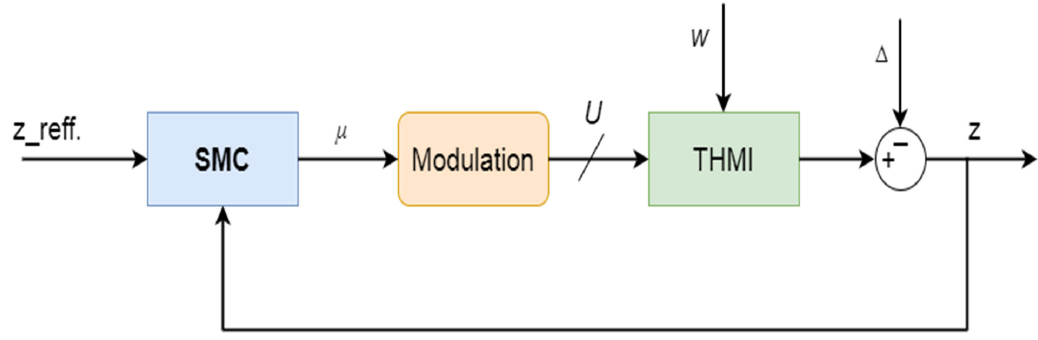
Figure 19. Block diagram of a closed-loop variant of SMC of a trinary hybrid MLI.